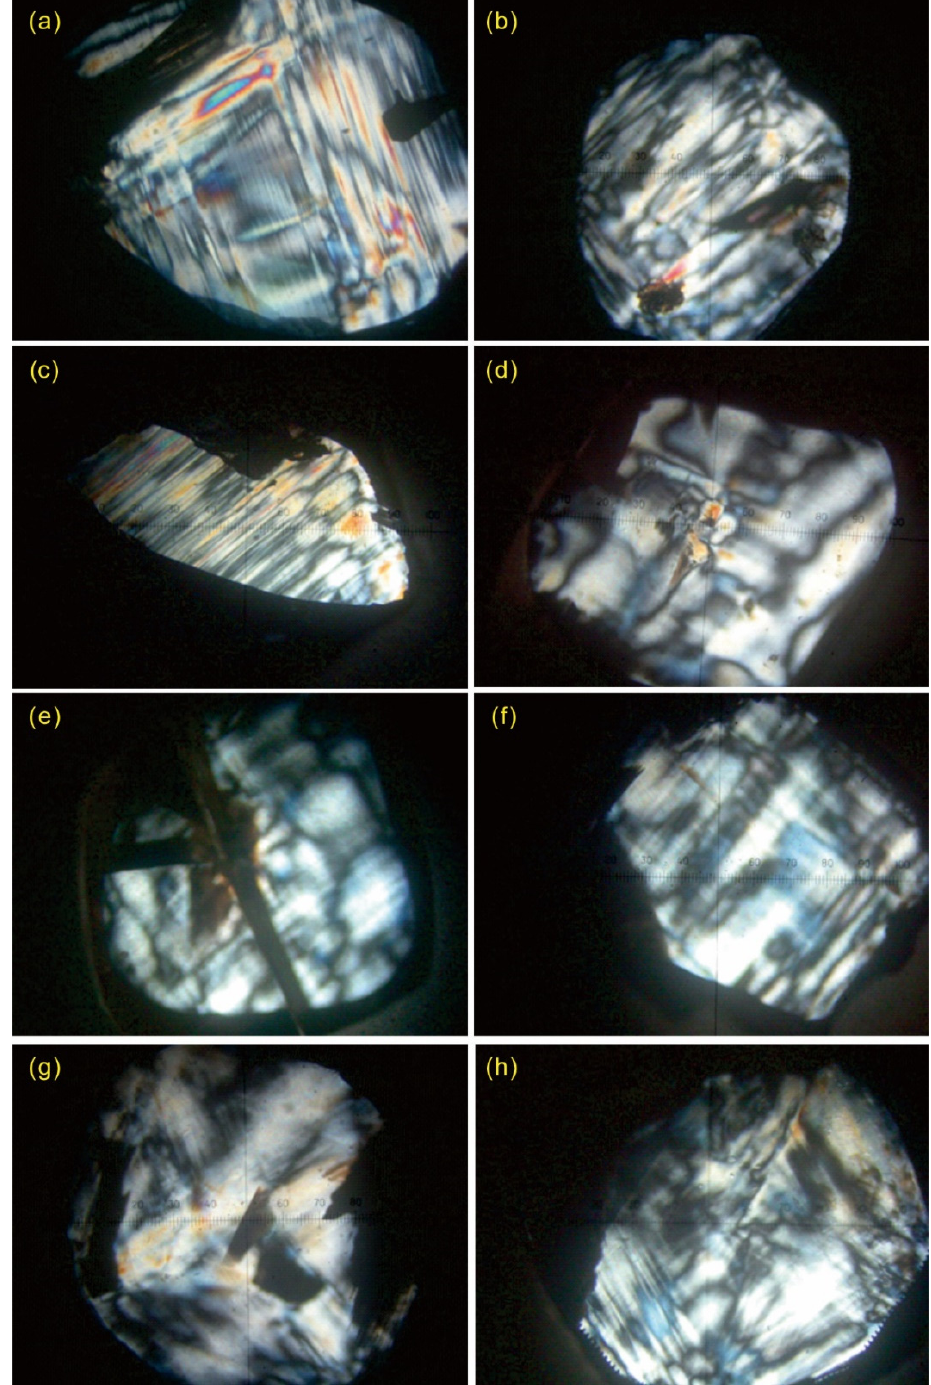
Figure 2. Extinction and interference patterns of representative samples of brown diamond slices from the Mengyin deposit under crossed polarizing filters. ( a ) A high level of interference color, straight extinction band and bow-tie extinction in MY-35; ( b ) An extinction band with poor straightness